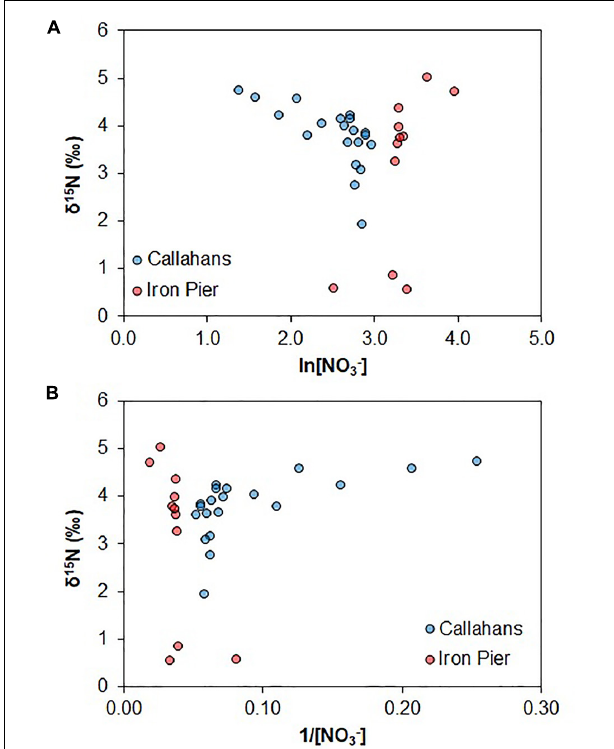
FIGURE 4 | Natural logarithm of NO 3 − vs. δ 15 N (A) and 1/[NO 3 − ] vs. δ 15 N (B) of coastal groundwater samples.